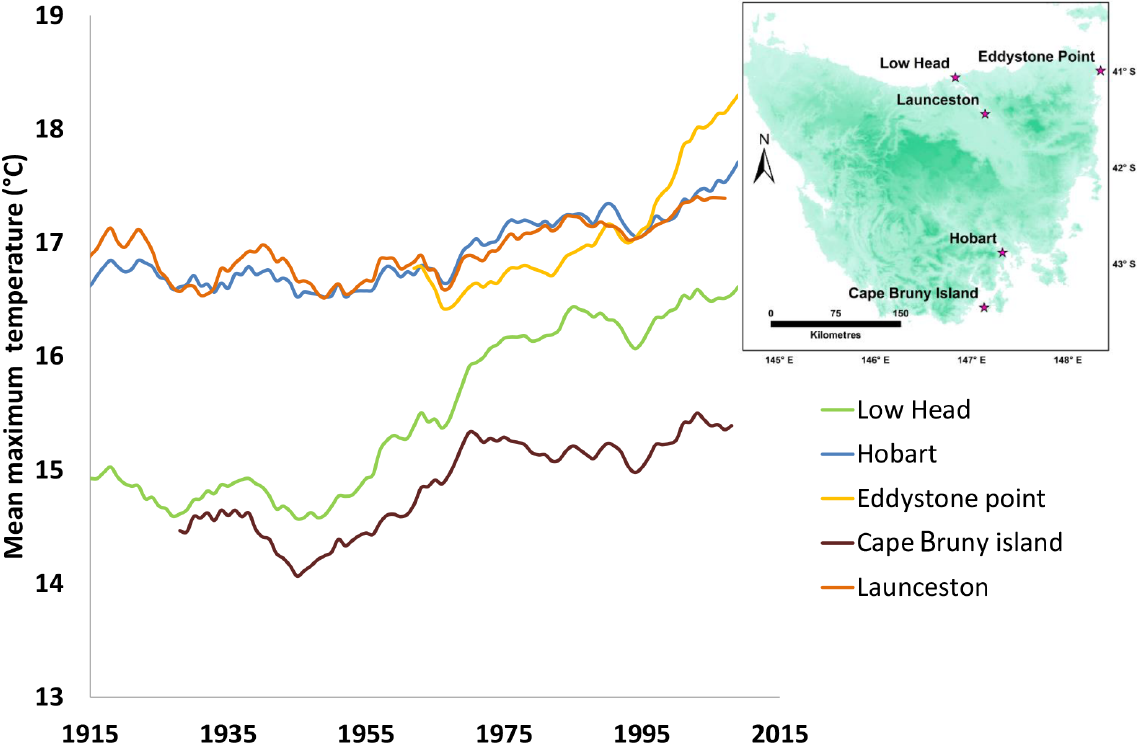
Figure 12. Meteorological record from eastern Tasmania (Bureau of Meteorology,